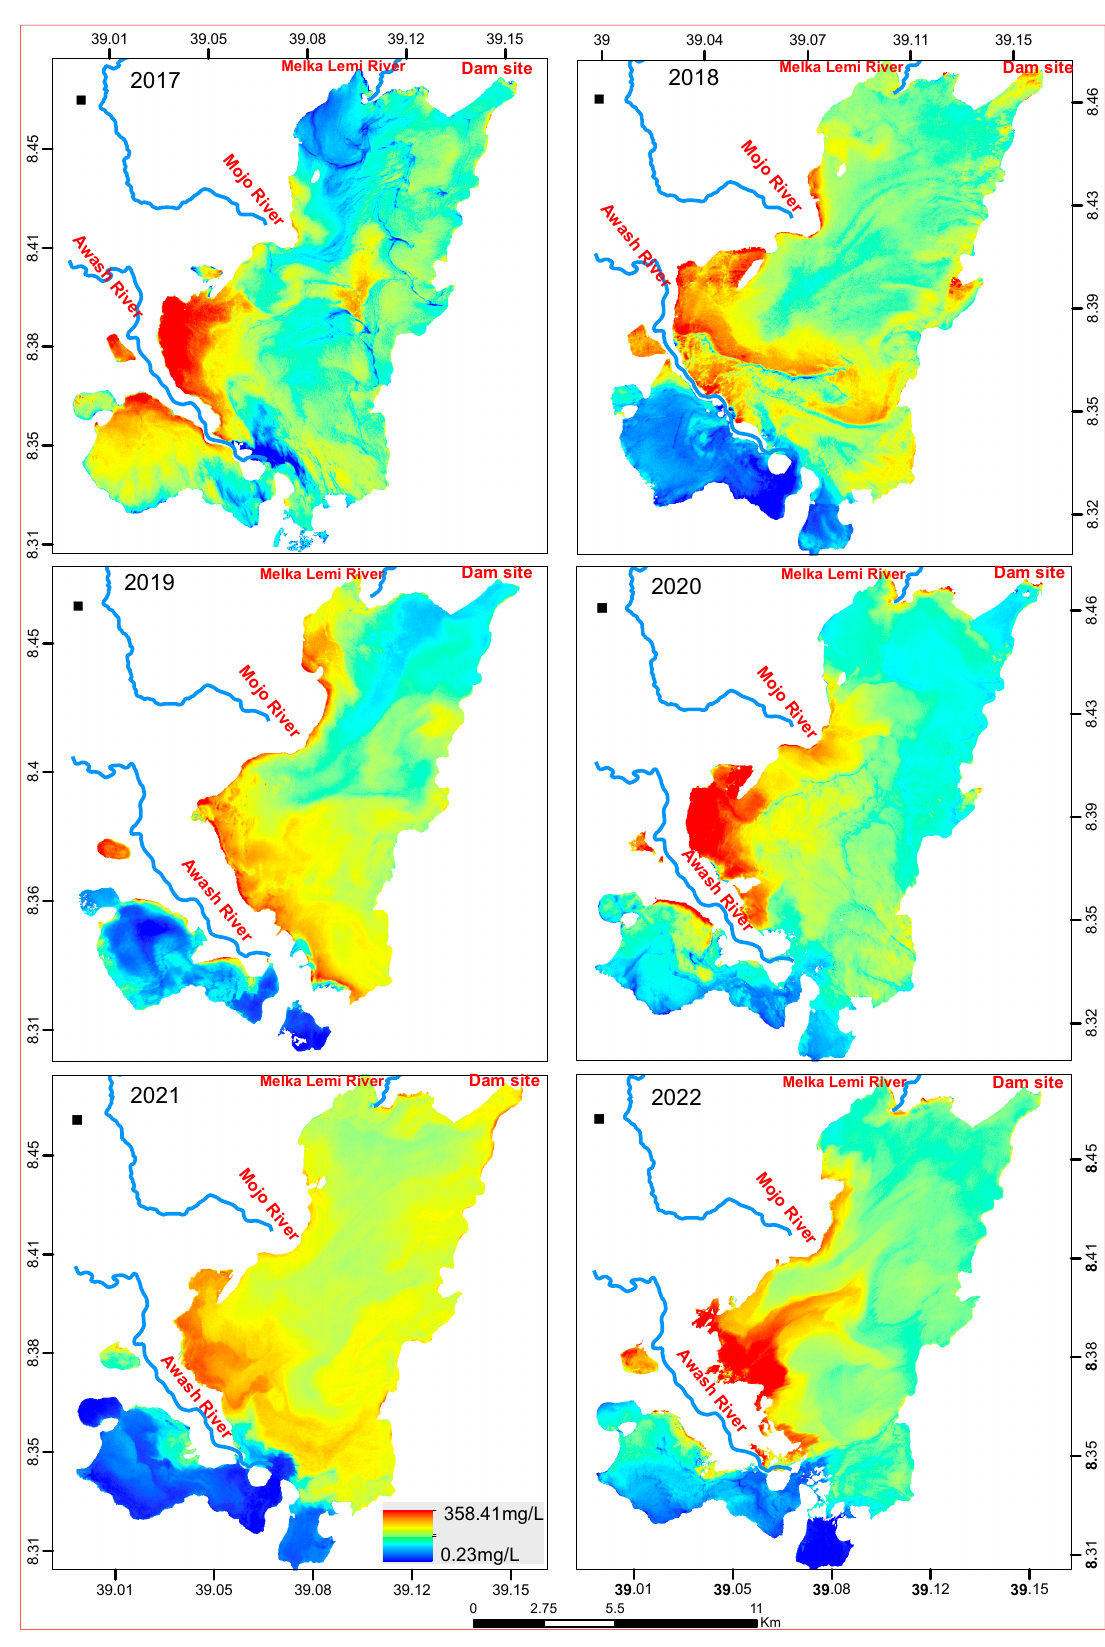
Figure 9. Annual distribution map of TSS (mg/L) from Sentinel-2 imagery using linear regression models.